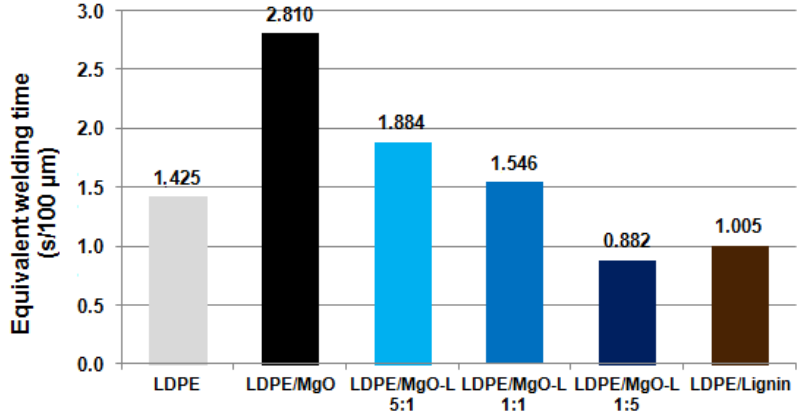
Figure 5. Required heating time of the tested films with relation to its thickness.